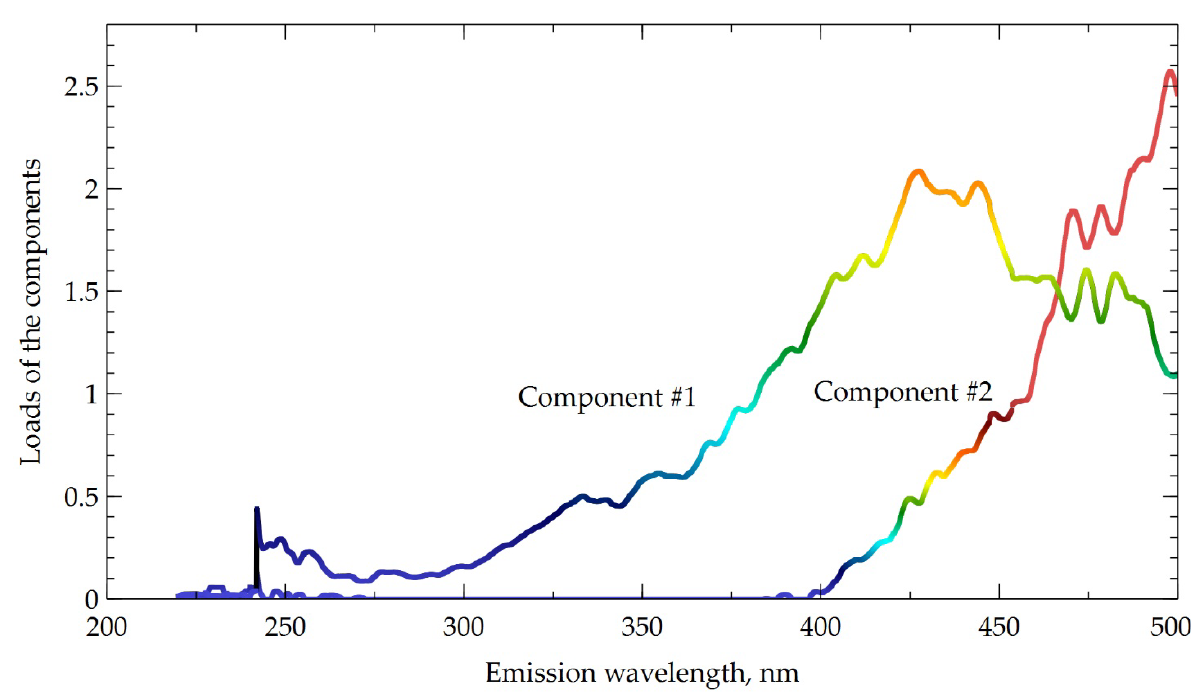
Figure 2. Components of PARAFAC model and their loads.